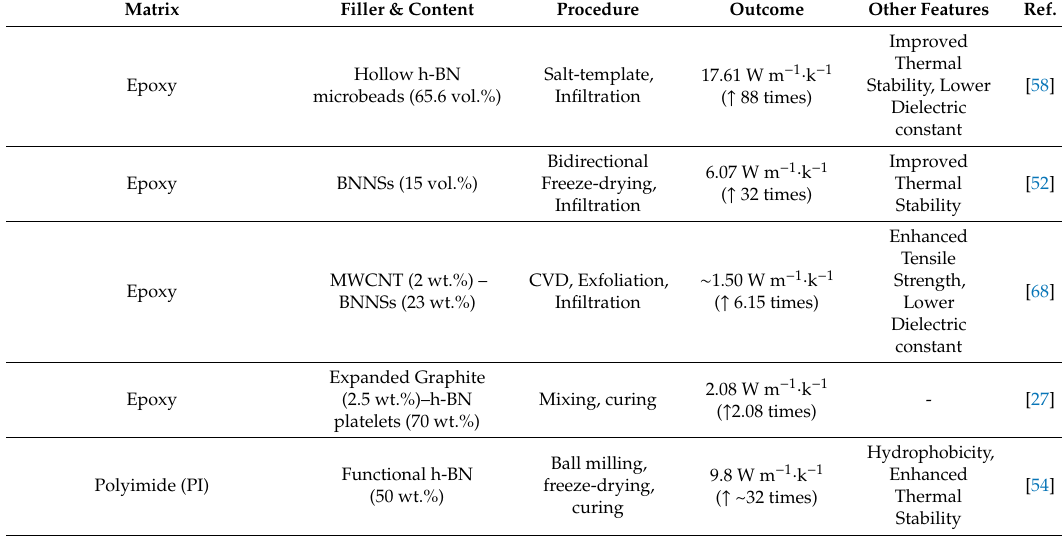
Table 1. Summary of recent PMCs reinforced with h-BN for enhancing thermal